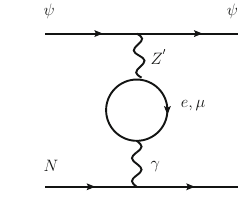
Fig. 1 Feynman diagrams for DM ψ scattering with nucleus